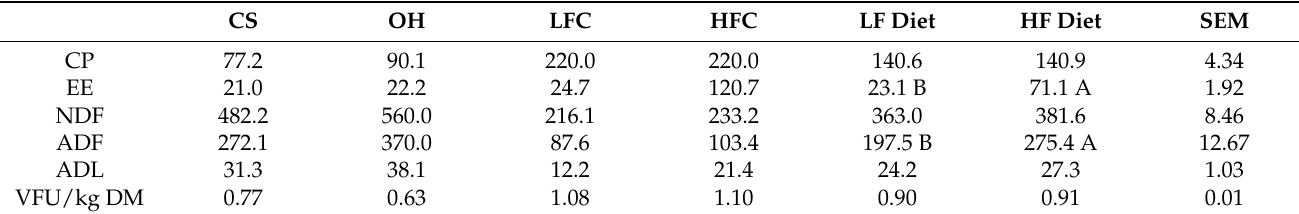
Table 2. Feeds and diets chemical composition (g/kg DM) and nutritive value (VFU/kg DM).